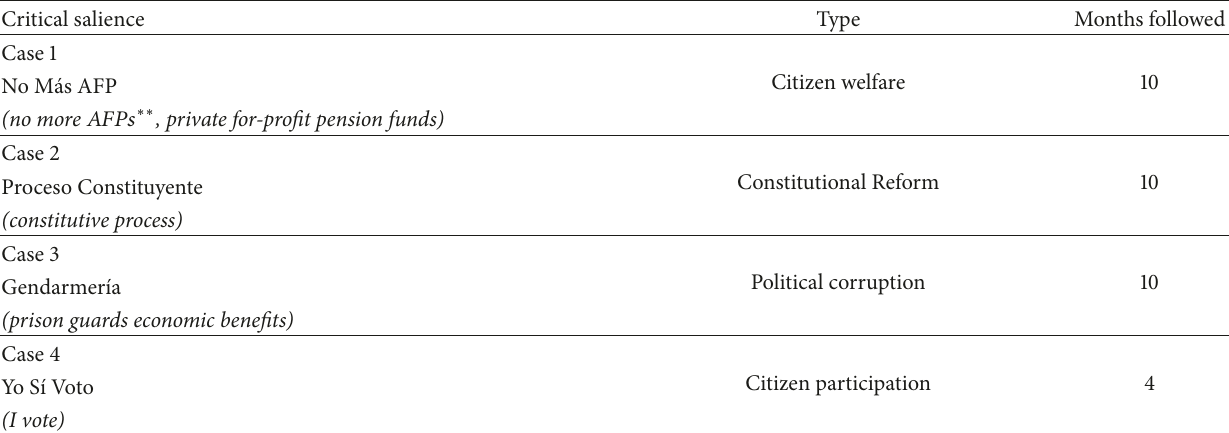
Table 1: Critical saliences occurred in Chile during 2016 and monitoring period on Twitter ∗ .